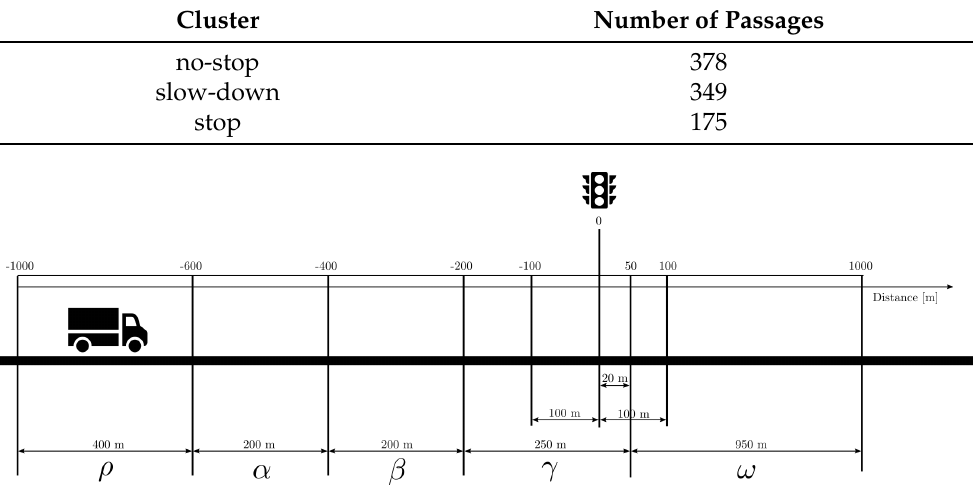
Figure 3. Details of the set of rules used in the study to determine the three clusters. The rules are mainly based on the approach to the intersection, and they are significantly laxer on the conditions of the velocity after the intersection. In all cases, the vehicle mean velocity over the immediate 400m segment 600m away from the intersection is greater than 60km/h. The 600m prior to the intersection is where the clusters are distinguished; for the no-stop case, the mean velocity is greater than 60km/h over the whole 600m segment. For the stop cluster, the vehicle stops completely (the velocity vanishes) at least once in the segment. Finally, for the slow-down cluster, the mean velocity is lower than the mean velocity on the previous segment but greater than 30km/h, and furthermore, the instantaneous velocity is greater than 30km/h. The mean velocity over the 1000m after the intersection for the vehicles in all the clusters needs to be greater than